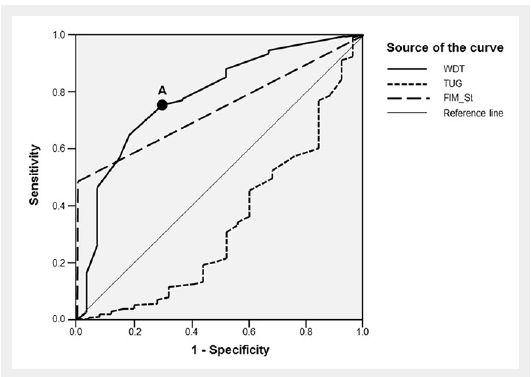
Receiver operating characteristic (ROC) curves for the motor tests at admission. Point “A” depicts the optimal cut-off value of 27 metres for dichotomisation of WDT. FIM_St = functional independence measures score for stair climbing; TUG = timed-get-up-and-go test at admission; WDT = walking distance at admission